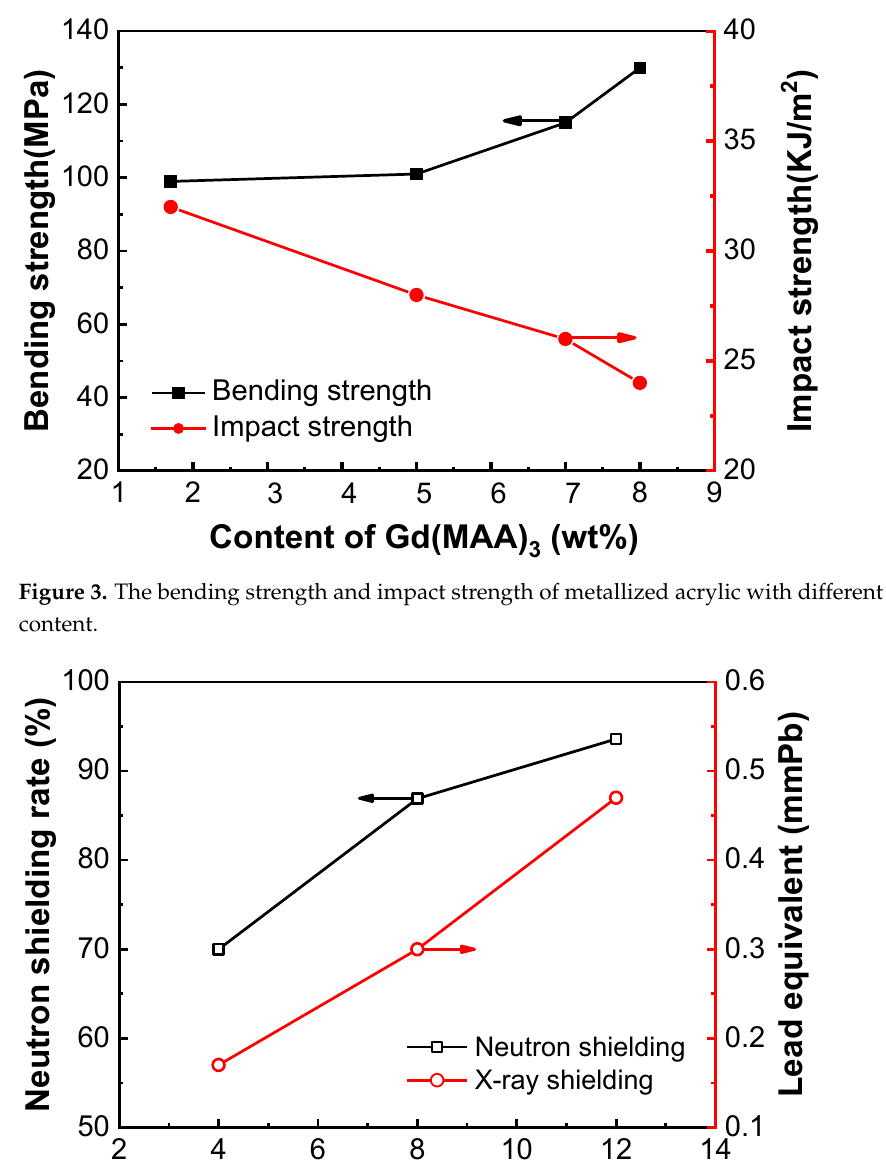
Figure 3. The bending strength and impact strength of metallized acrylic with different Gd(MAA) 3 content.